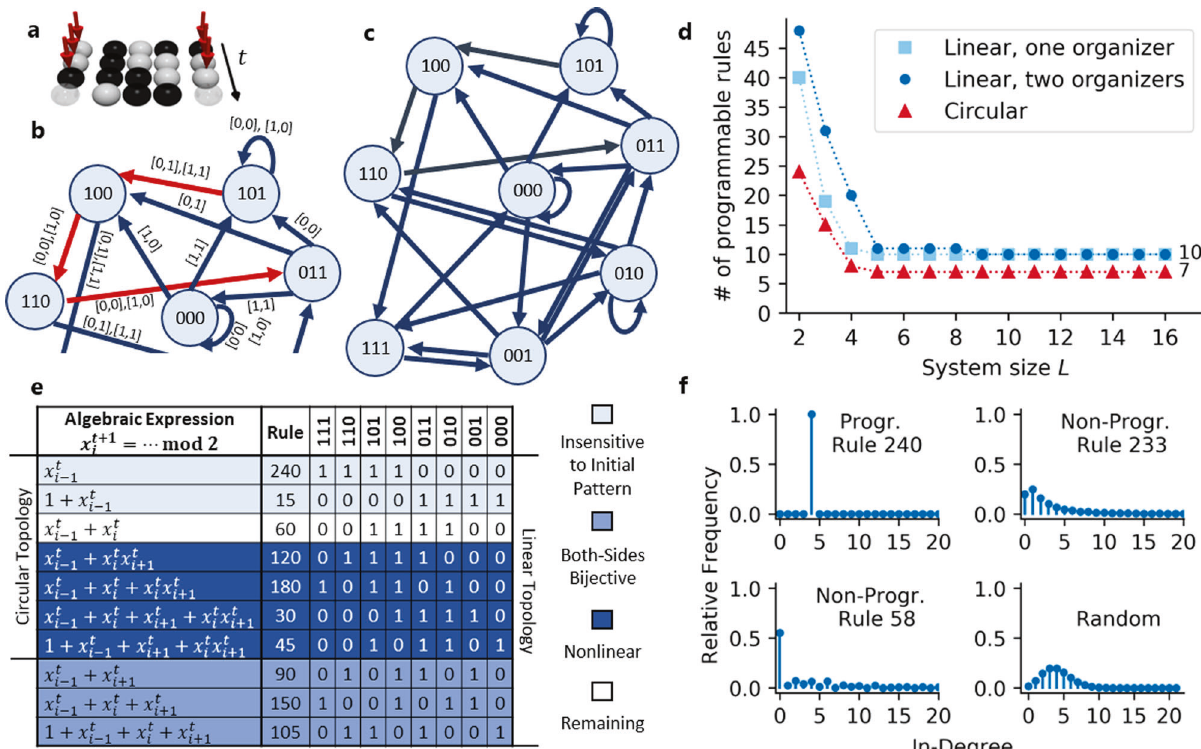
Fig. 2 Patterning graph. a Illustration of the patterning dynamics of a small system L ¼ 3, steered from initial pattern 101 to target pattern 011 (last row) in a linear topology with two organizer cells (cells with red arrows) under rule 86 (cf. Fig. 1). ( b ) Part of the corresponding patterning graph, with nodes representing patterns and arrows possible transitions. The organizer inputs that can trigger a transition are indicated next to the corresponding arrow, e.g., ½ 0 ; 0 (cid:3) when the left and right organizer cell both supply a ‘ 0 ’ signal (sometimes multiple input combinations are possible). The path corresponding to ( a ) is highlighted in red. c A system with a given update rule permits programmable pattern formation if the corresponding full patterning graph is strongly connected, i.e., there is a path from every node to every other node (regardless of the required inputs). d The number of distinct programmable rules decreases monotonically with the system size and reaches a plateau-value (10 for linear topology, 7 for circular topology). e The update rules that remain programmable for all system sizes with circular ( fi rst 7) and linear topology (all shown rules), listed in their algebraic form with x t i denoting the state x at position i at time t , decimal rule number, and update map. Different shades indicate properties of the rules as indicated in the legend. f Statistical characterization of patterning graphs by their in-degree distribution (linear systems with two organizer cells, L ¼ 16 bulk cells, and three different exemplary rules; distributions shown up to in-degree 20). All programmable rules have the same distribution as the shown rule 240, whereas the distribution of non-programmable rules is broad (shown examples: rule 233 and 58), except for the identity and complement rule (distributions for all rules shown in Fig. S2). For comparison, the in-degree distribution of a randomized graph is also shown (random redirection of arrows to any node with equal